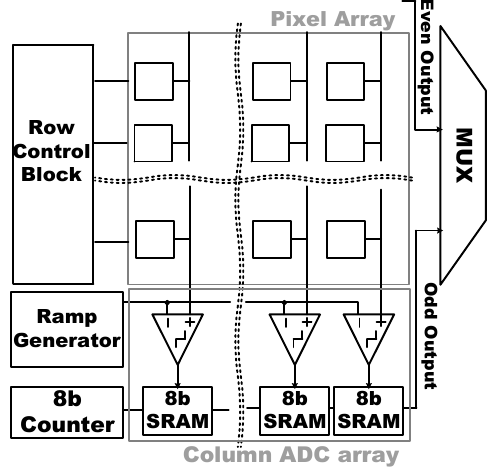
Figure 3. A block diagram of the proposed CIS.